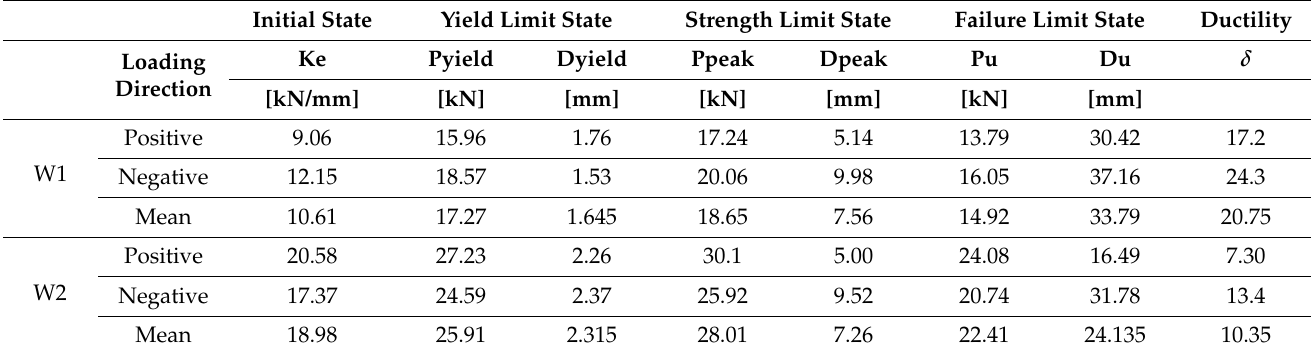
Table 3. Seismic parameters corresponding to W1 and